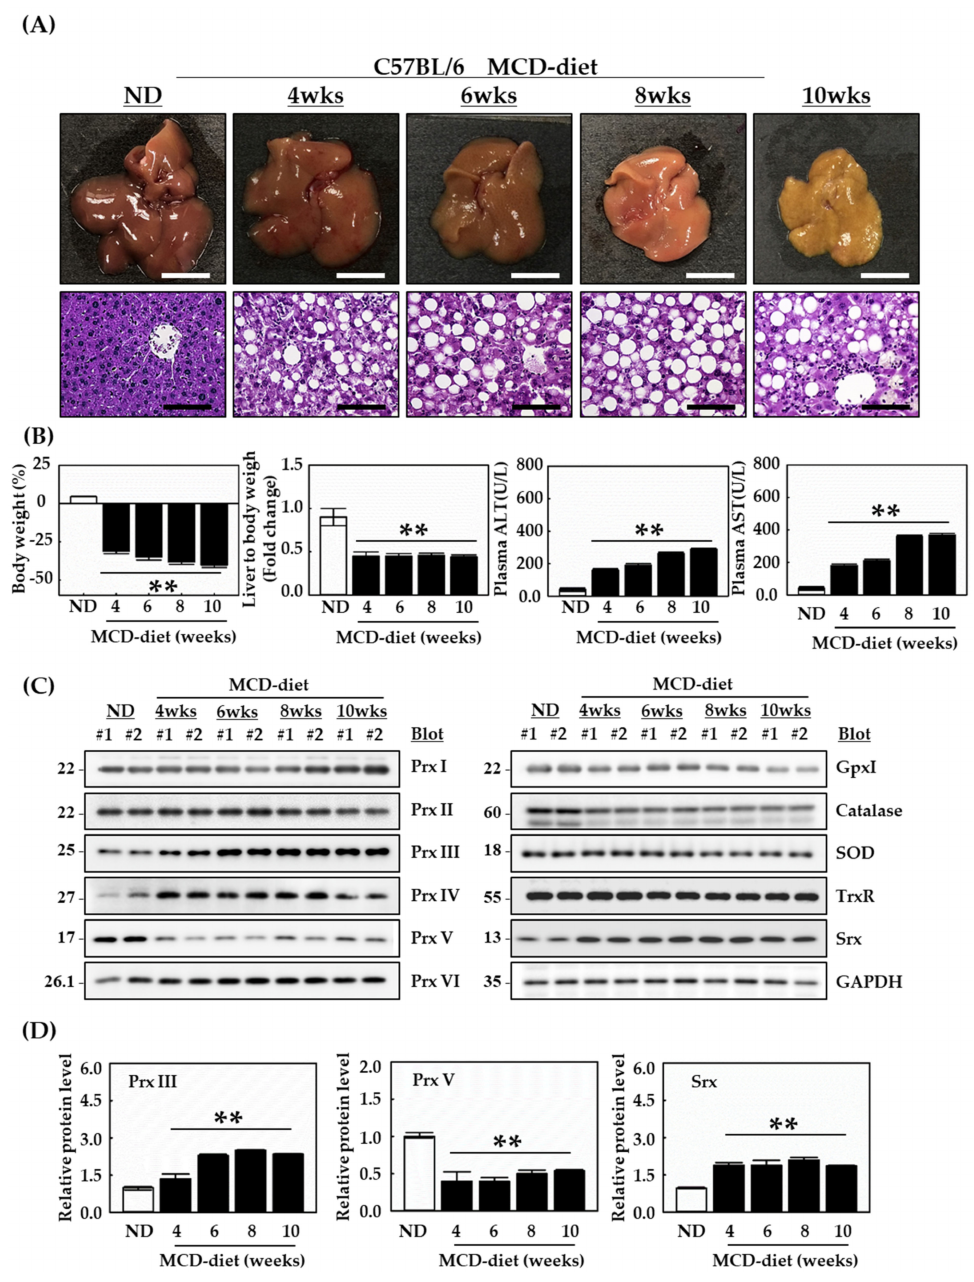
Figure 1. MCD diet-induced hepatic damage and antioxidant protein expression levels in C57BL/6 mice. Male, 8-week-old C57BL/6 mice were fed the ND or MCD diet for 10 weeks. The mice were sacrificed at 4, 6, 8 and 10 weeks. ( A ) H&E staining of representative liver sections at 4, 6, 8 and 10 weeks. Each liver sample was fixed with 4% formaldehyde in phosphate-buffered saline at 4 ◦ C overnight and embedded in paraffin. The liver sections (4 µ m thick) were stained using H&E.